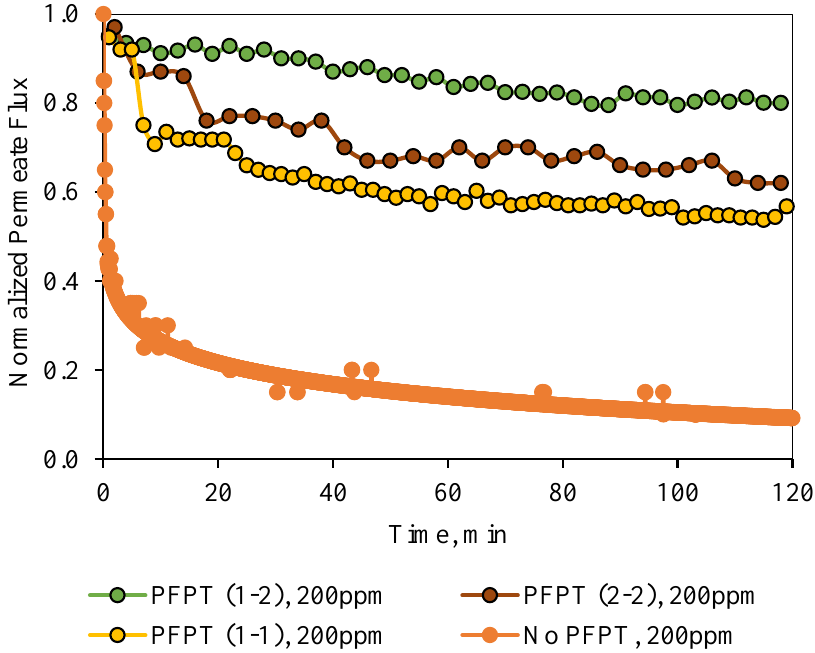
Figure 13. Normalized permeate flux decline for normal filtration and the 1-1, 1-2, and 2-2 PFPT as a function of time for a feed of 200 ppm.